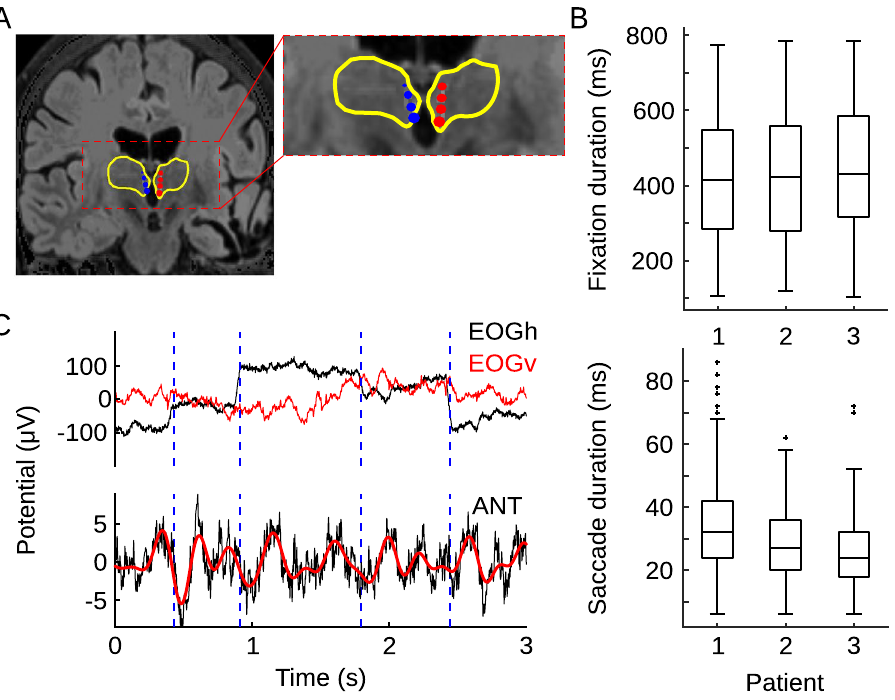
Figure 1. Electrode locations, example field potential trace and behavior. ( A ) Bilateral leads implanted into the anterior nuclei of the thalamus marked with blue (right ANT) and red (left ANT) in a single patient (4 contacts per side). Inter-contact space of 3 mm (contact height of 1.5 mm with 1.5 mm spacing). Yellow contours depict boundaries of the thalamus. ( B ) Distribution of fixation (upper panel) and saccade (lower panel) durations for three patients. Box plots indicate 25th, median and 75th percentile, whiskers extend to extreme values not considered outliers while outliers are marked with crosses. Because we used the EOG signal to define time points of fixation and saccade onsets, it is possible that smaller eye movements were not detected (see Limitations). ( C ) An example of 3 s long recording trace with horizontal (EOGh; black trace) and vertical (EOGv; red trace) part of EOG signal (upper panel). Horizontal dashed lines indicate fixation onset time points. The same interval of 3 s field potentials from an example site in the ANT. Black trace presents raw signal; red trace shows signal filtered in 2–5 Hz (lower